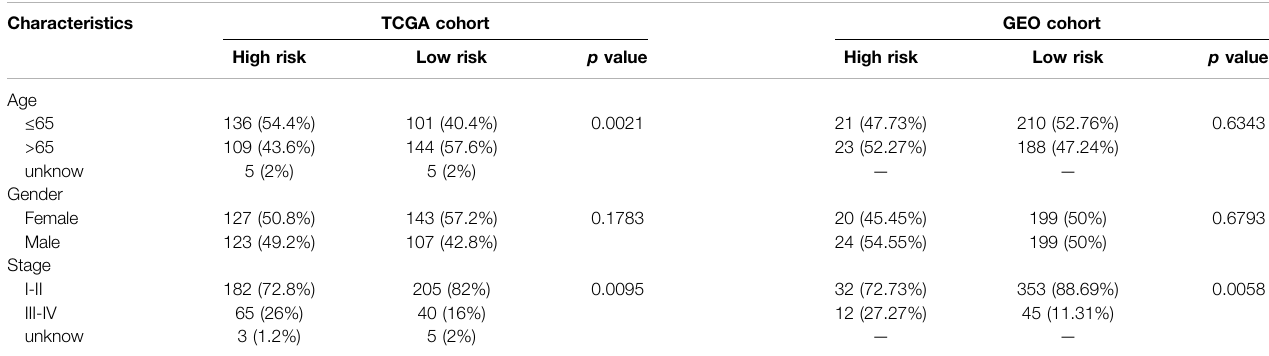
TABLE 2 | Baseline characteristics of the patients in different risk